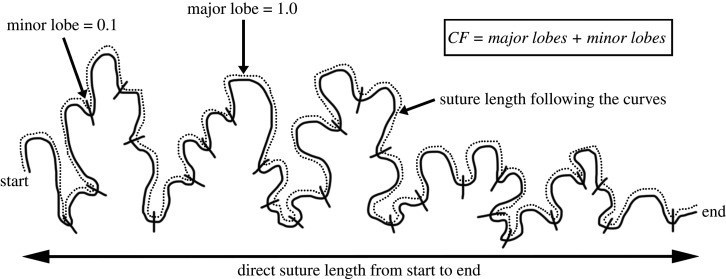
Depiction of SI and SCI calculation [51].